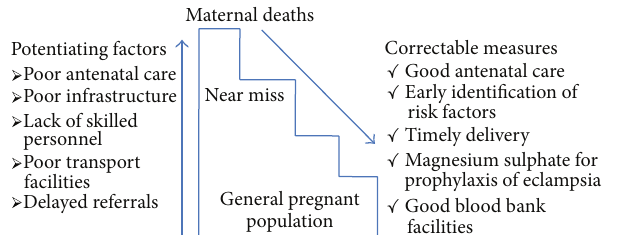
Figure 1: Diagram representing potentiating factors of maternal death and the correctable measures which need to be